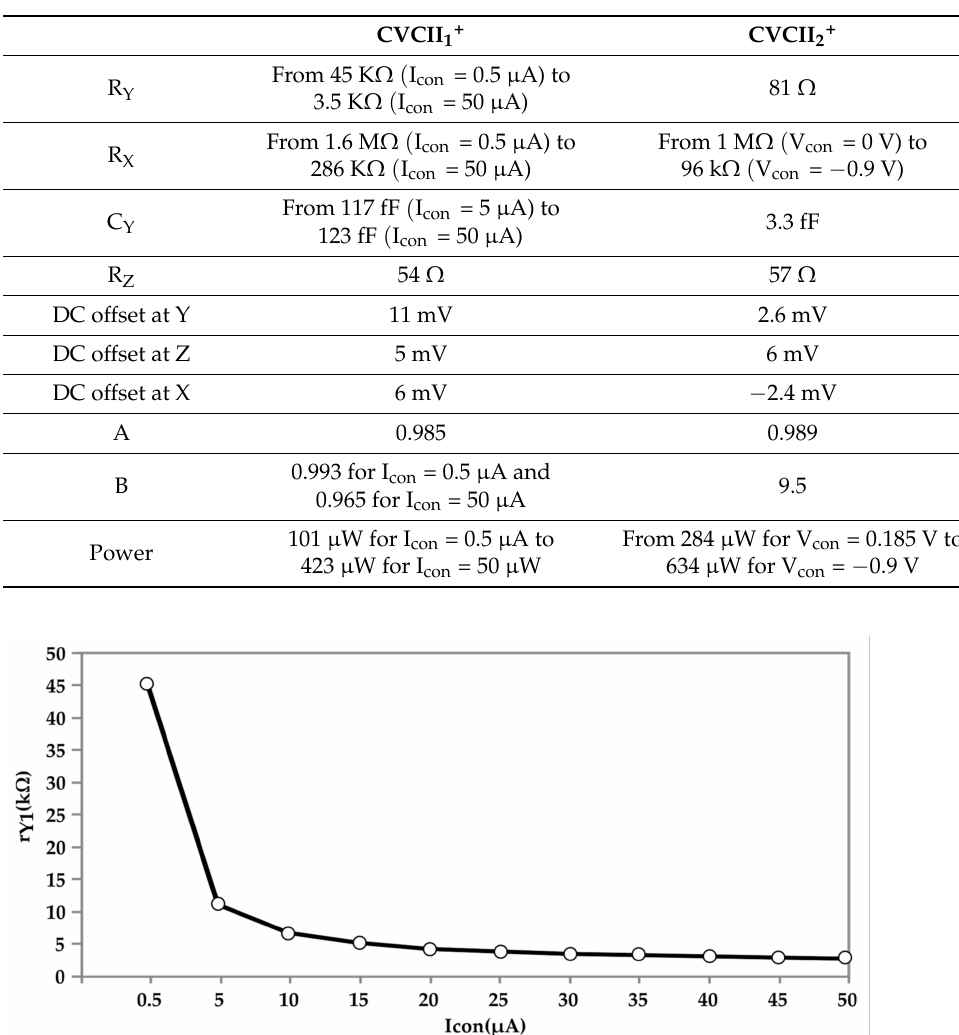
Table 2. Performance parameters of the designed CVCII 1+ and CVCII 2+ .